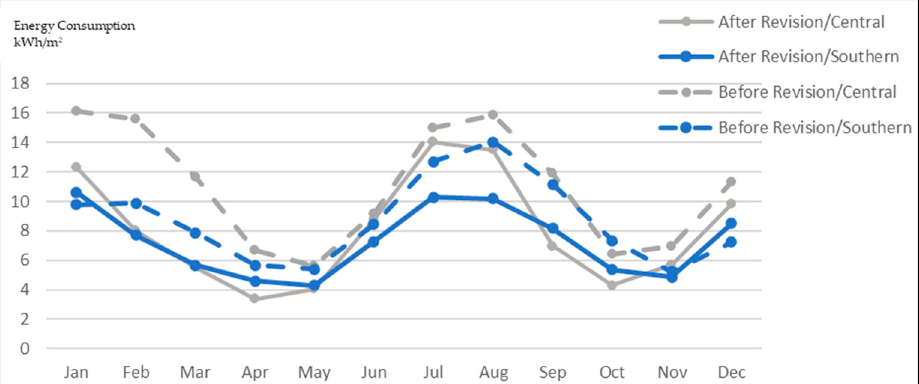
Figure 2. Line chart of the energy consumption of the courthouse buildings based on region and the revision of the building insulation thickness standard.